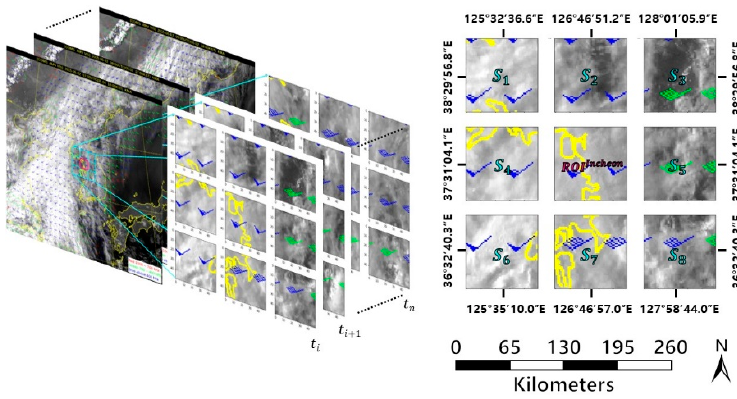
Figure 6. Continuity of satellite images with the change in time.